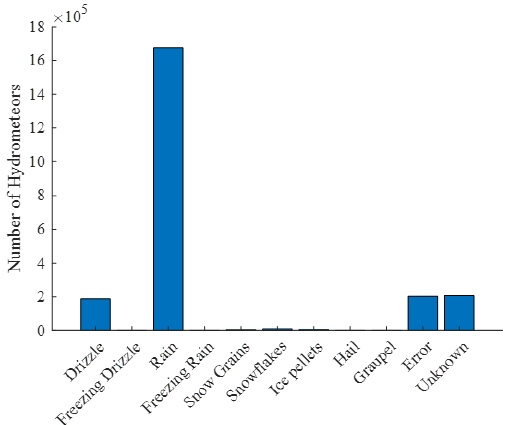
Figure 4. Number and type of hydrometeors recorded during the total measurement period.